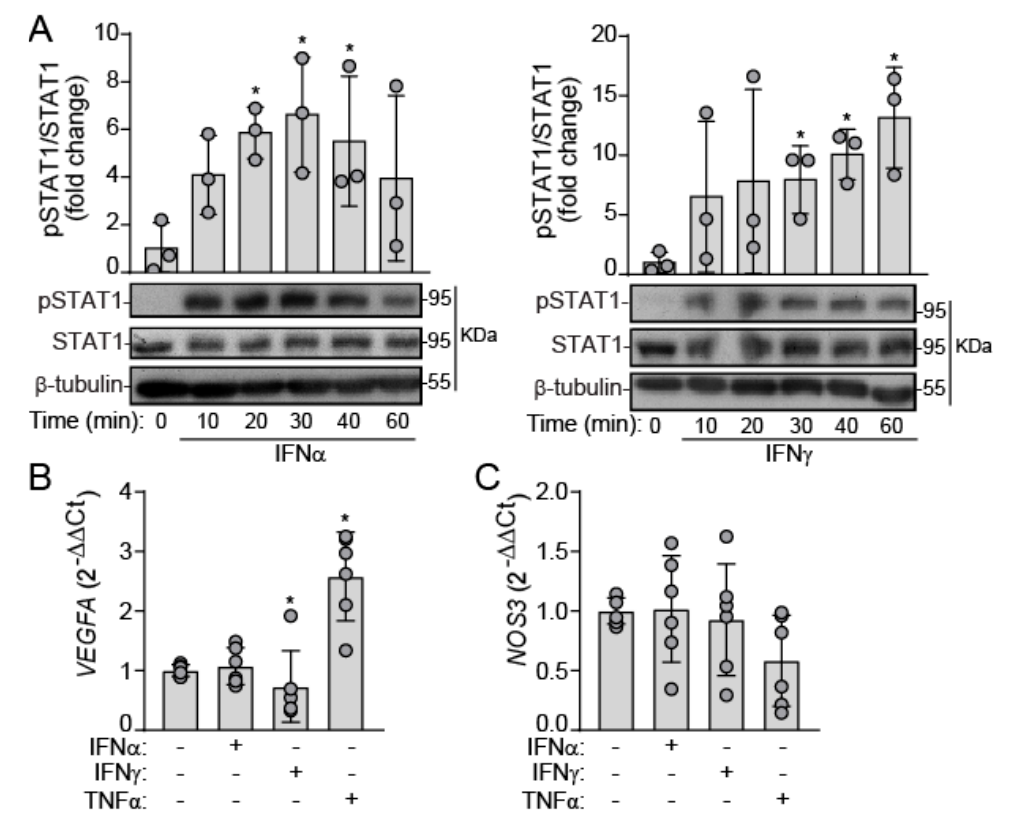
Figure 1. Type I and II interferons promote STAT1 activation but do not affect VEGF and NOS3 expression in VEC. ( A – C ) Mixed VEC monolayers were challenged with the indicated ligands under static conditions for the specified times. ( A ) Western blot analysis of STAT1 canonical activation (phosphorylation at tyrosine 701); n = 3 isolates from independent valve donors. To quantitatively compare samples from different blots, Western blot data were expressed as fold change. ( B , C ) qPCR analysis of VEGFA ( B ) and NOS3 ( C ) gene expression after 24 h activation; n = 6. IFN α indicates 100 ng/mL IFN- α ; IFN γ , 100 ng/mL IFN- γ ; TNF α , 5 ng/mL TNF- α . Datasets A–C: Mean ± S.D. One-Way ANOVA statistics, followed by the Dunnett post-hoc test (vs. control), as indicated in Methods. * p < 0.05 compared with the control group.